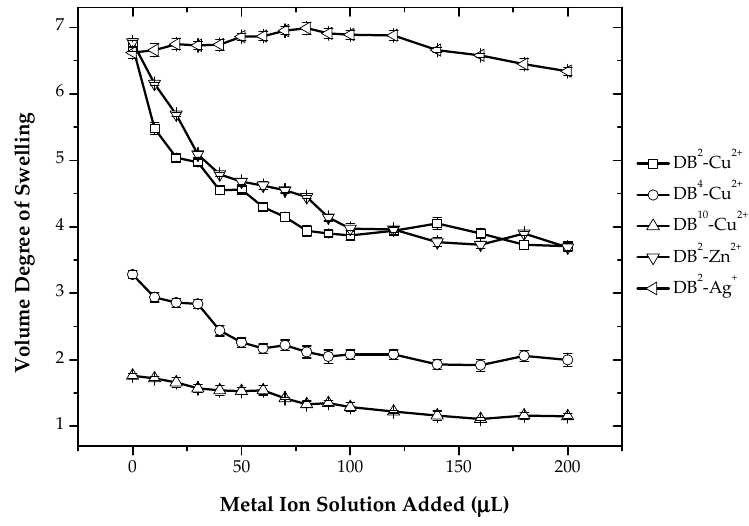
Figure 4. Variation of the volume degree of swelling with respect to varying amounts of CuSO 4 solution (0.01 M) for different crosslinking densities of hydrogels and variation of the volume degree of swelling of DB 2 hydrogels with respect to the addition of different metal ions for System I